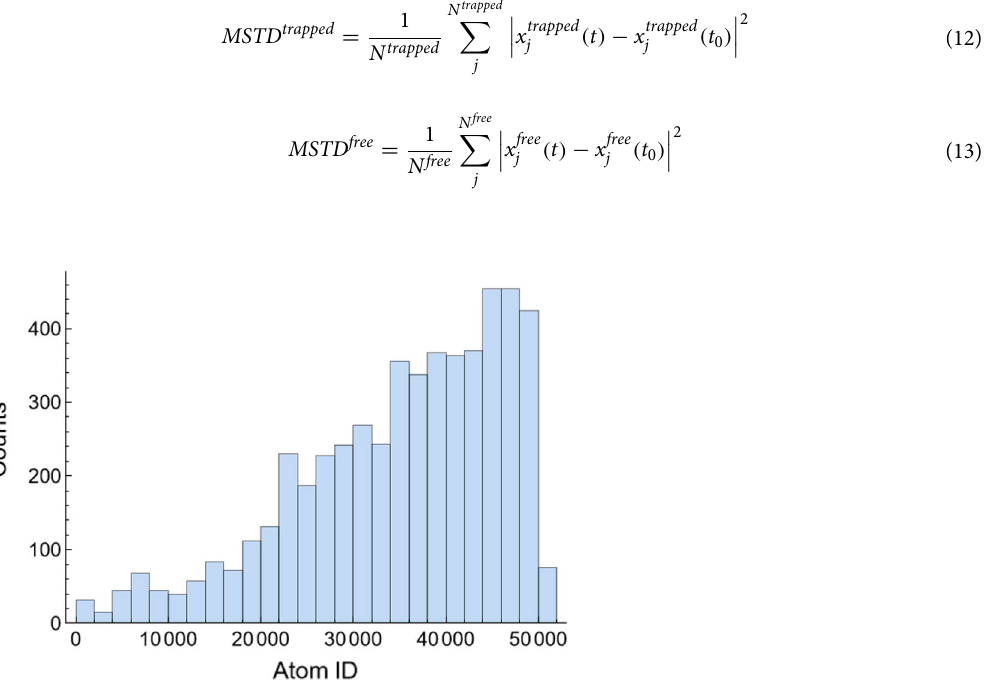
Figure 11. Histogram of Al atoms on the Al–0.5Ni surface.